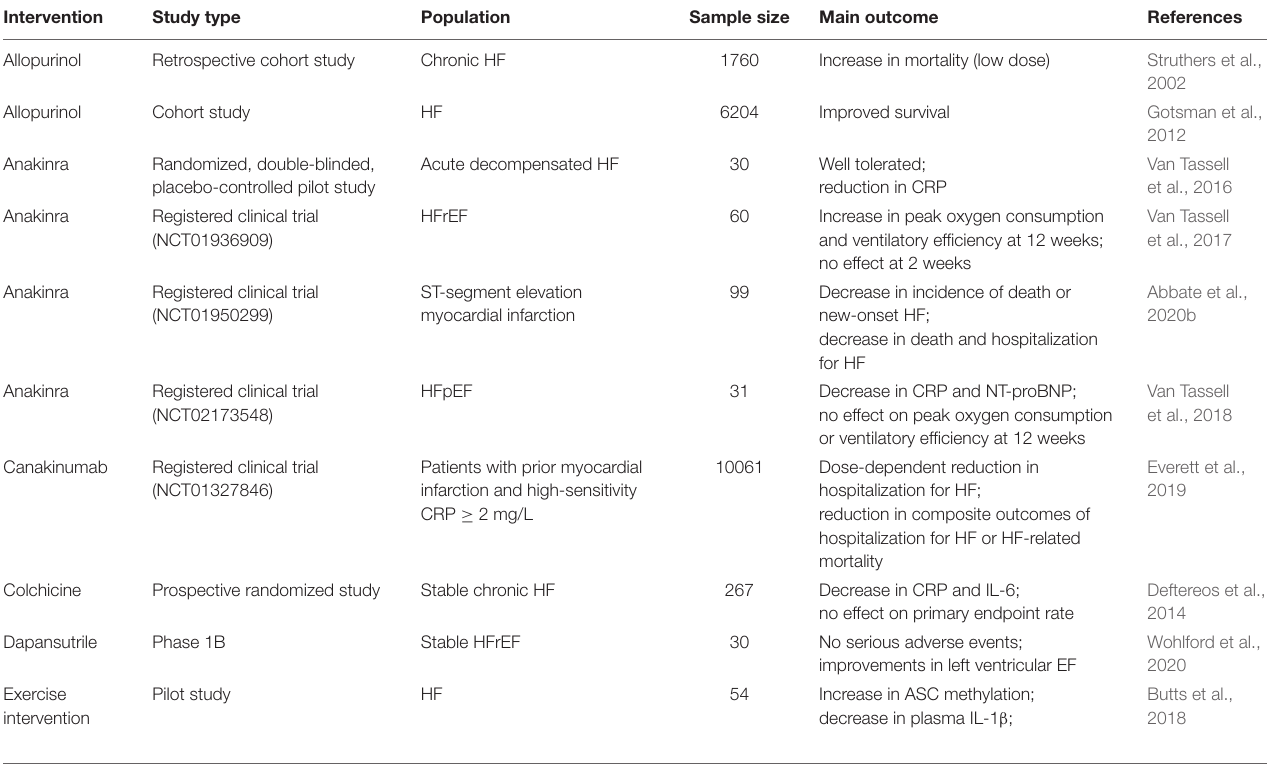
TABLE 2 | Clinical Studies targeting NLRP3 inflammasome in patients with